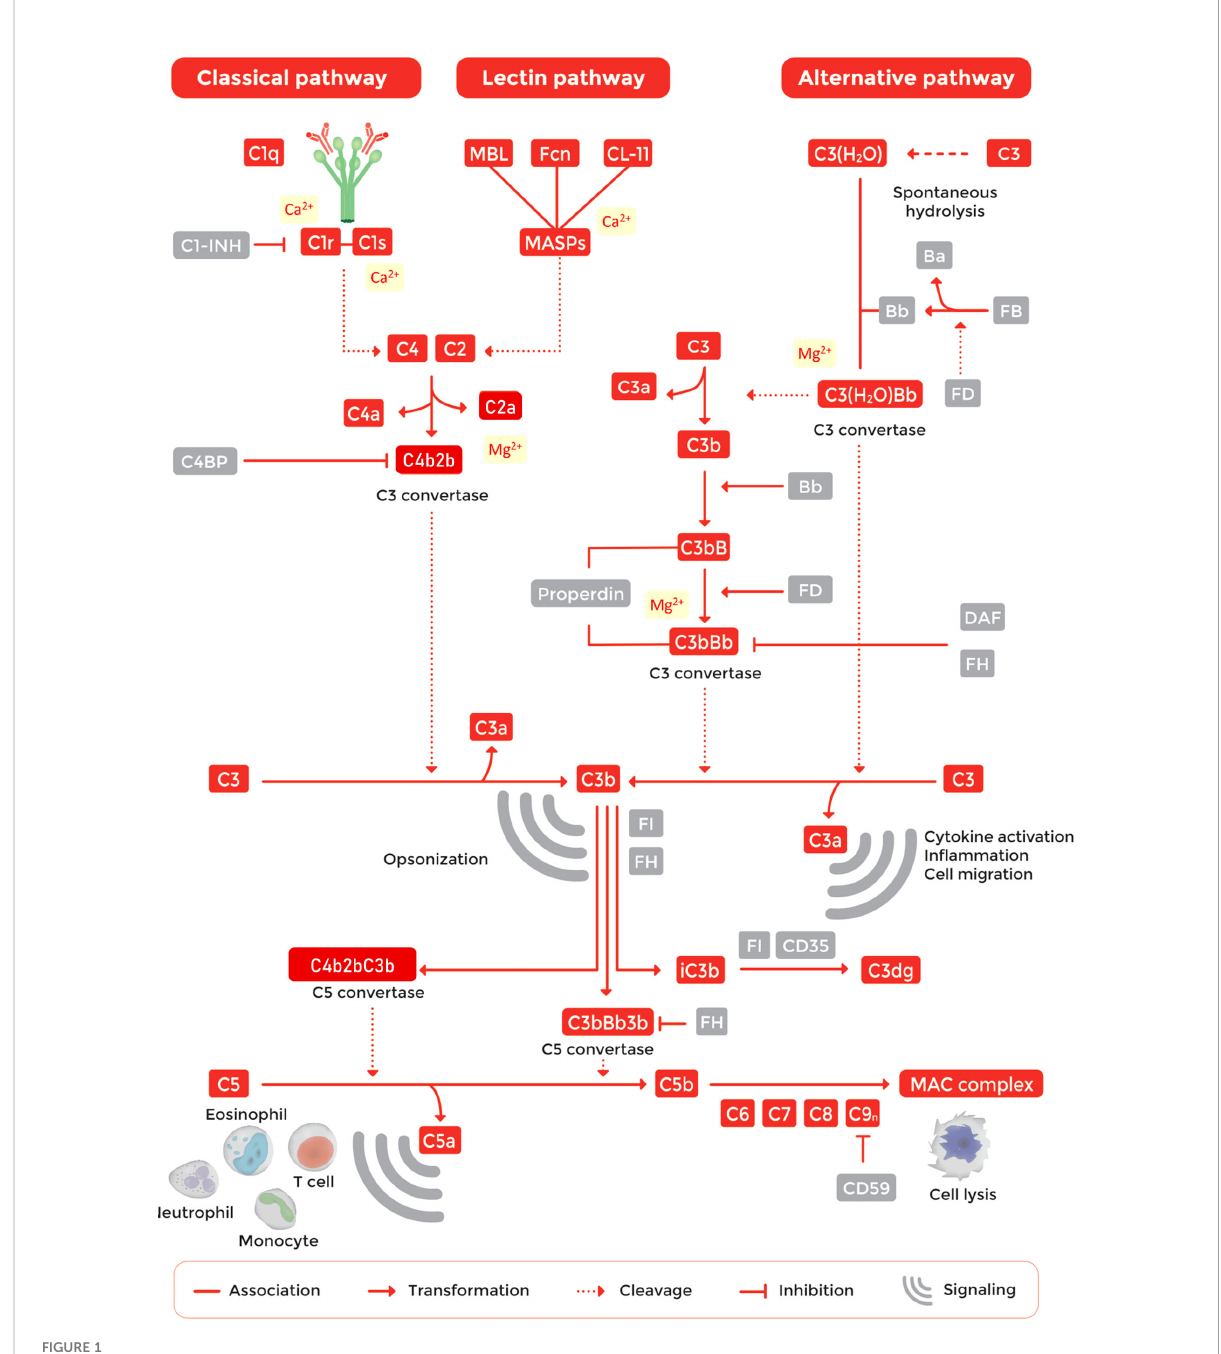
FIGURE 1 Overview of the complement